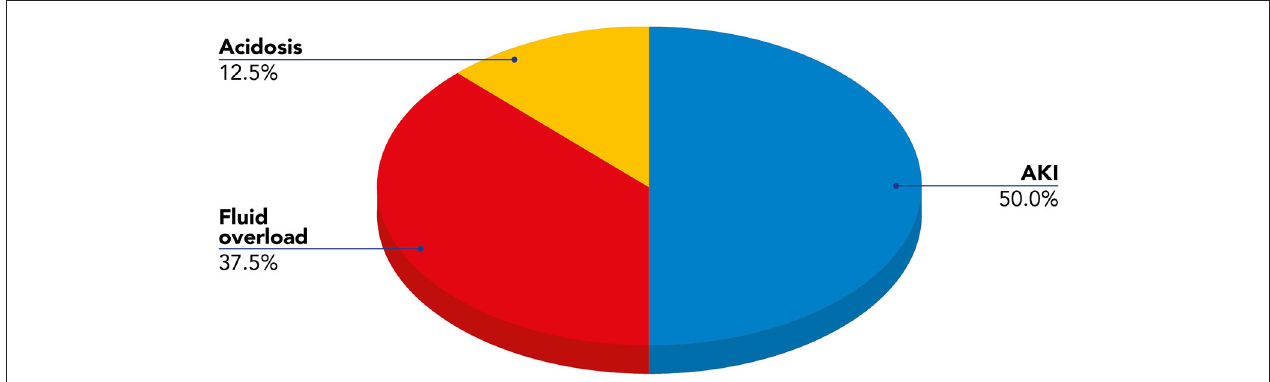
FIGURE 3 | Indications for blood purification (CKRT plus hemoperfusion) in our cohort of pediatric patients with septic